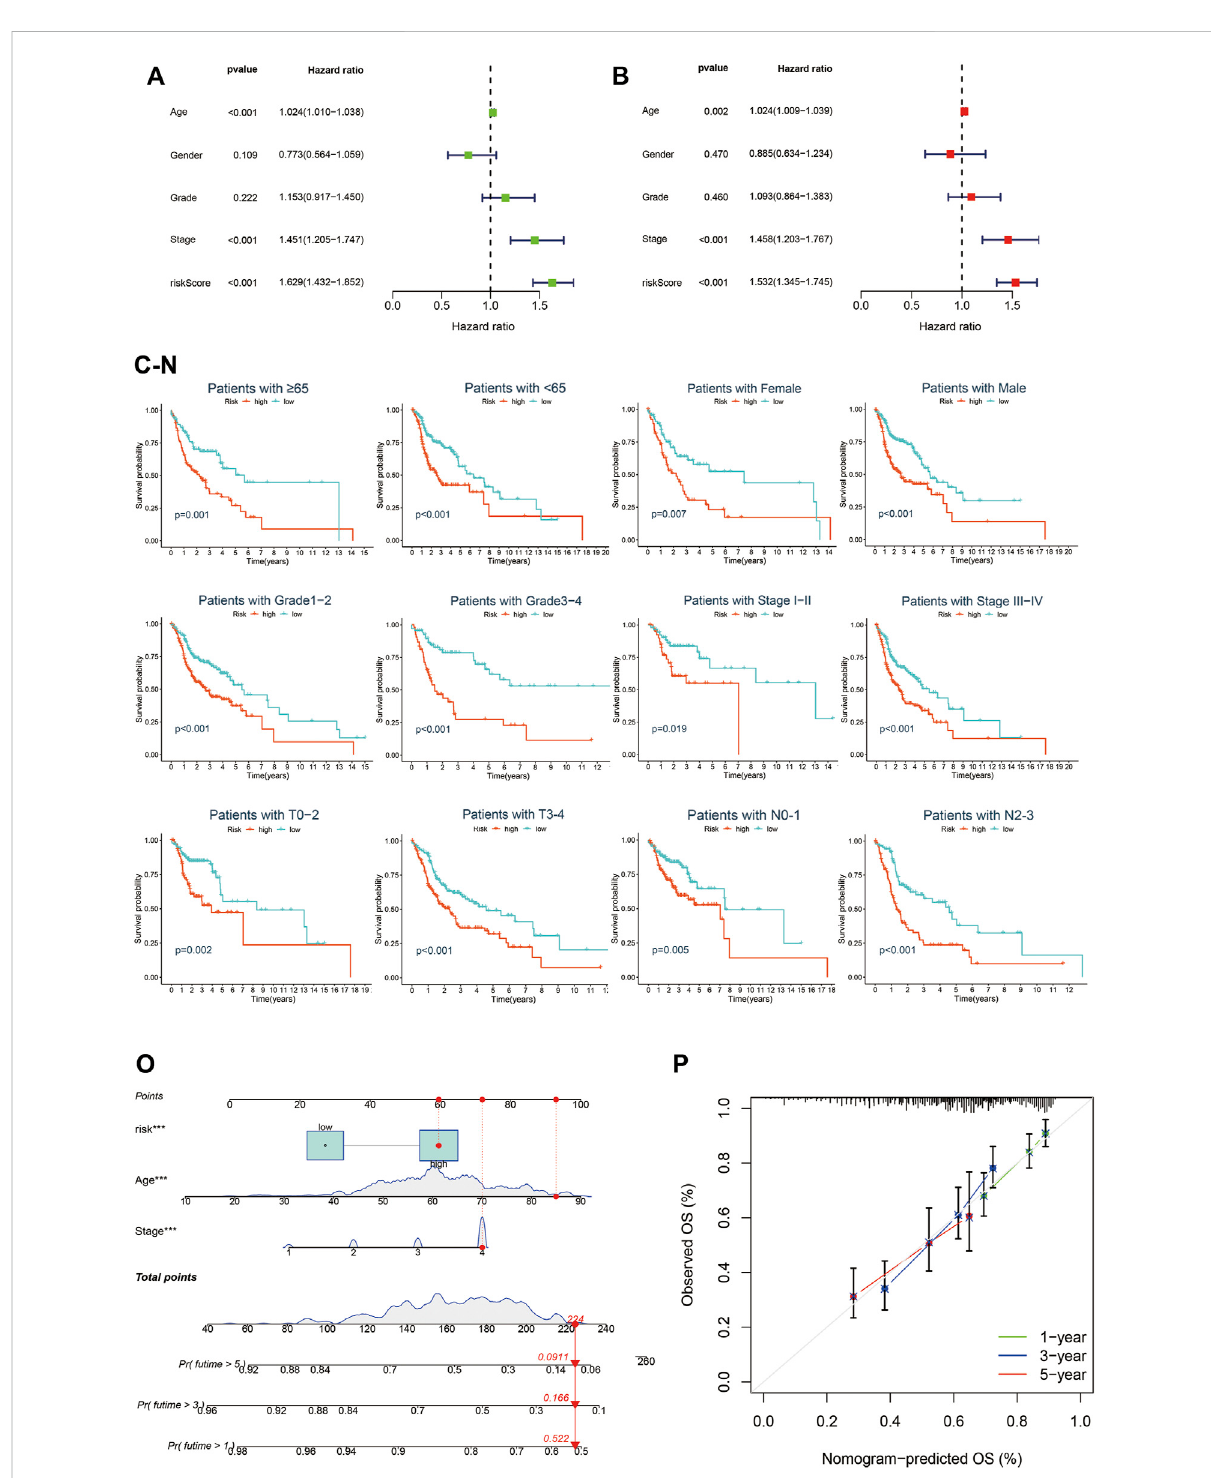
FIGURE 6 Cupr-RLPS is an independent prognostic indicator. Univariate Cox regression analysis (A) and multivariate Cox regression analysis (B) all demonstratedtheriskscore wastheindependentprognostic factorinthetraining cohort.Survivalanalysis strati fi edbyage (C,D) ,gender (E,F) ,grade (G,H) , clinical-stage (I,J) , T stage (K,L) , and N stage (M,N) . Nomogram predicted the 1, 3, and 5 years ’ OS (O) and calibration curve (P) showed the consistency between the nomogram prediction and the actual